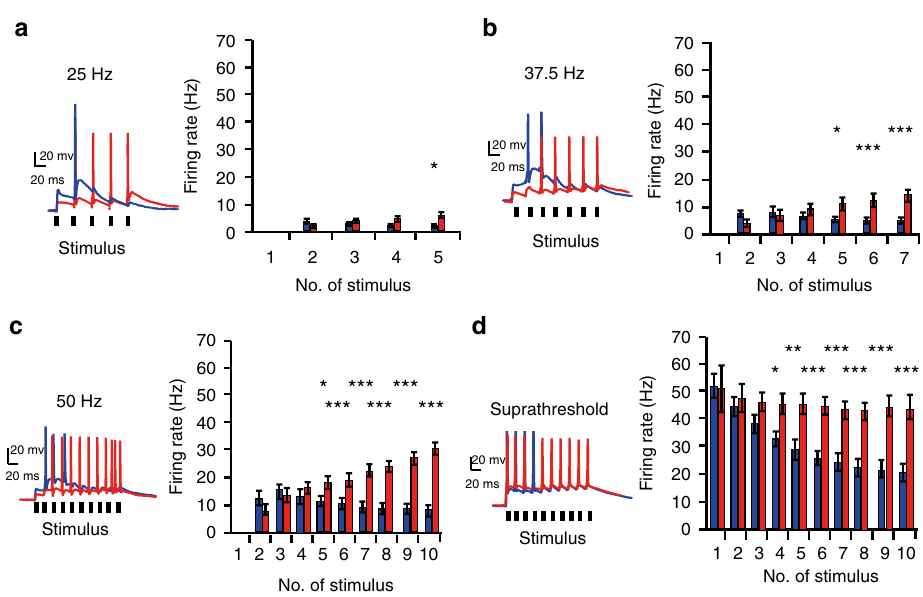
Fig. 4 The in fl uence of CKAMP44 on fi ring rate increases with optic tract stimulation number and frequency. a – c The difference in fi ring rates of relay neurons between genotypes increases with stimulation frequency and with the number of stimuli in the train. The optic tract was stimulated with 25 Hz ( a , wildtype: n = 50, CKAMP44 − / − : n = 67), 37.5 Hz ( b , wildtype: n = 49, CKAMP44 − / − : n = 28), and 50 Hz ( c , wildtype: n = 45, CKAMP44 − / − : n = 55) and fi ring rates for different stimulus numbers were calculated by dividing the cumulative action potential number by the respective stimulation duration (mean ± SEM, Mann – Whitney test). d Firing rates are signi fi cantly higher in relay neurons of CKAMP44 − / − mice than in those of wildtype mice when stimulating such that the fi rst stimulus was just suprathreshold and elicited an action potential (wildtype: n = 31, CKAMP44 − / − : n = 11, mean ± SEM; responses to 3, 4, and 5 stimuli: Mann – Whitney test, other responses: t -test). * p < 0.05, ** p < 0.01, *** p <